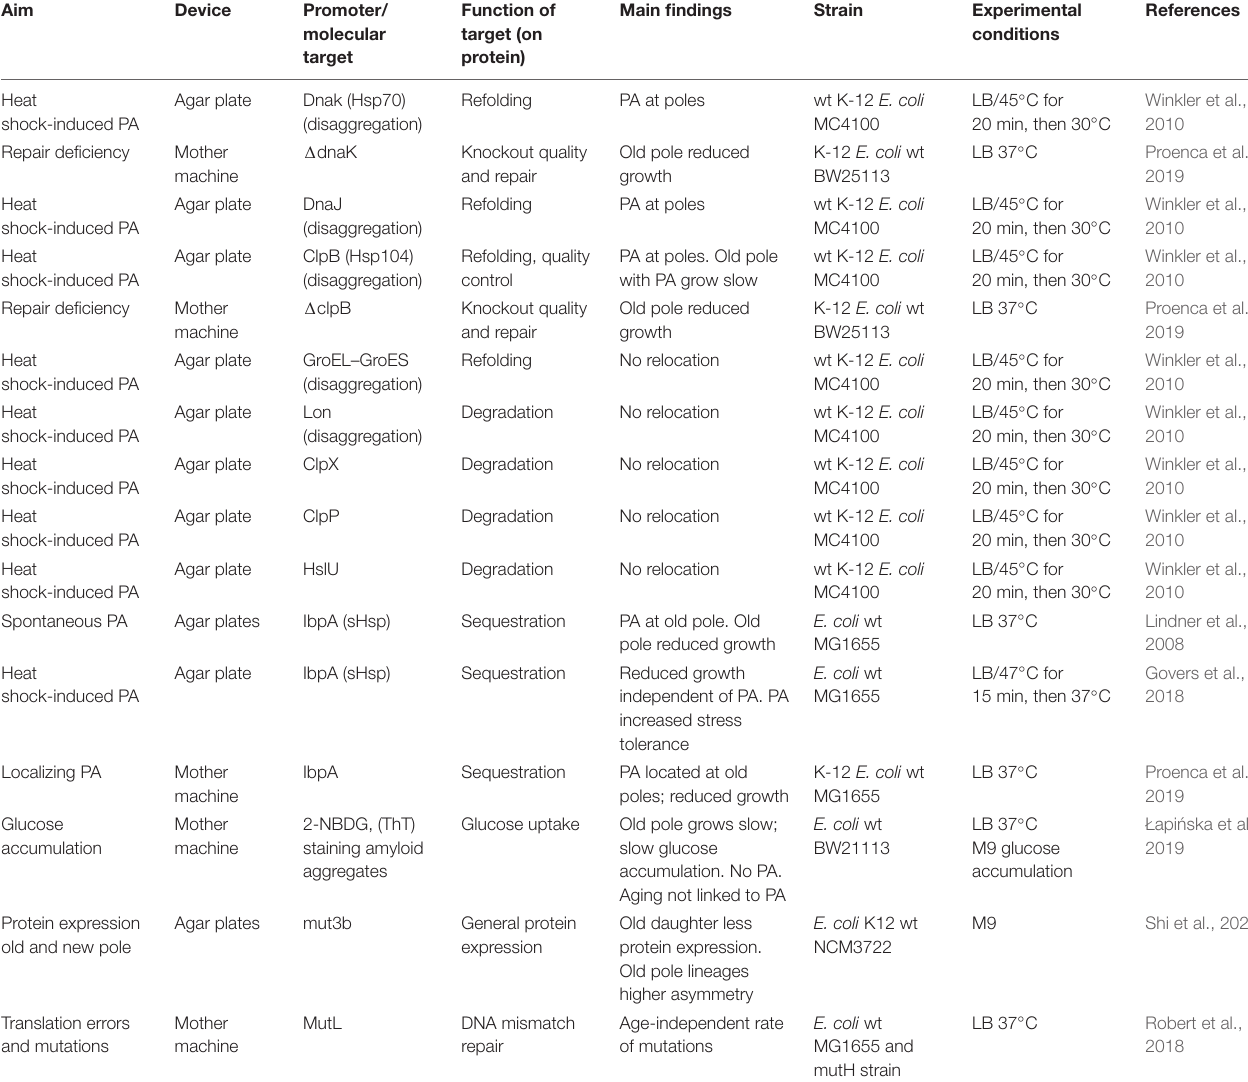
TABLE 1 | Examples of single-cell studies on aging using molecular